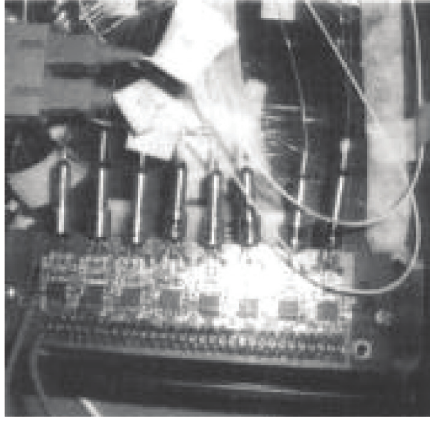
Figure 6: The appearance of the encapsulated PIN Table 2: Comparison between experimental and proposed theoretical data.